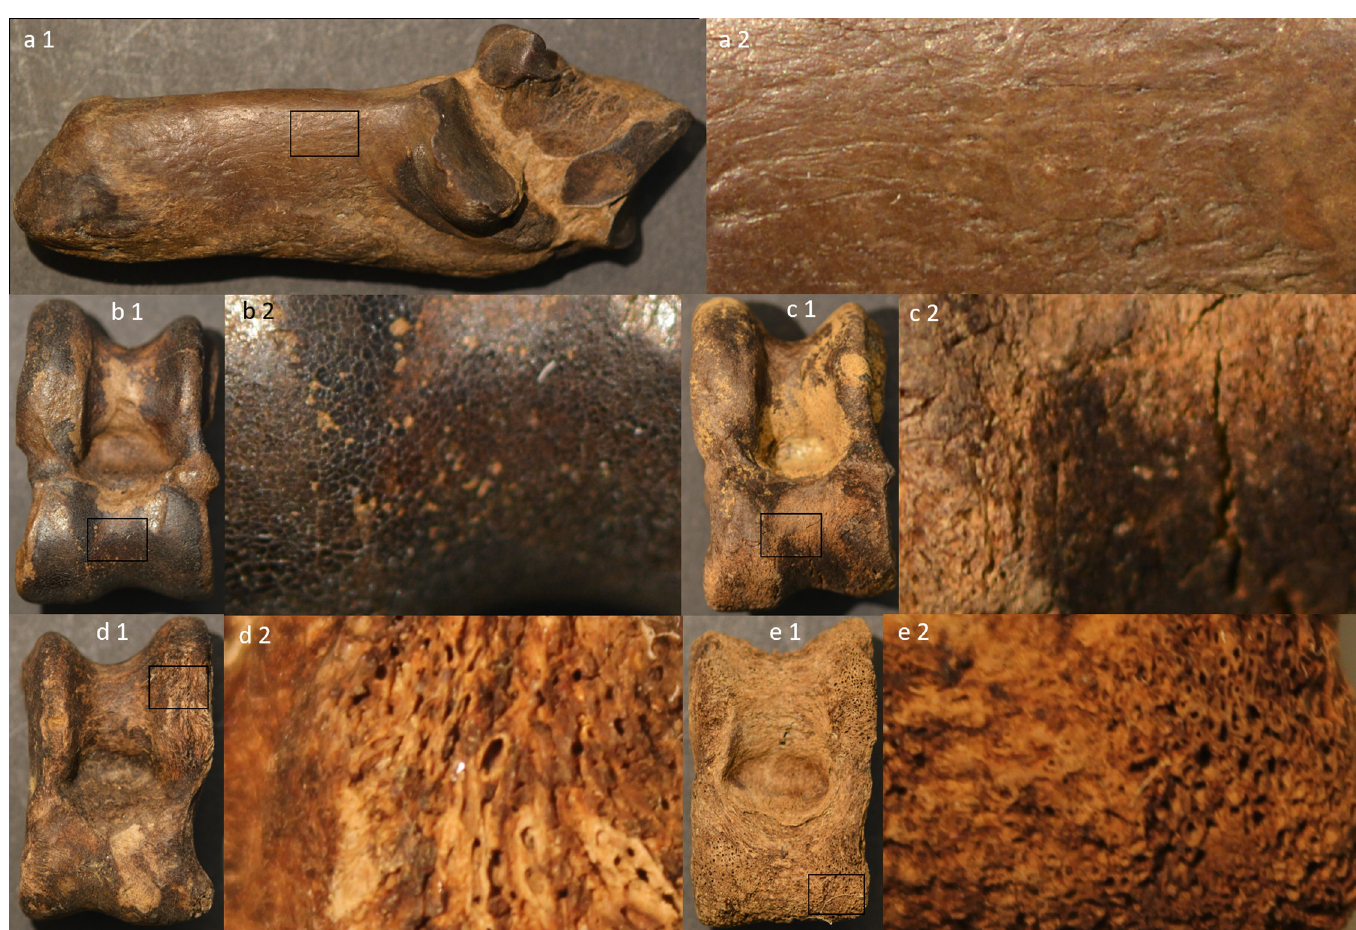
Fig 6. Weathering I categories exemplified with bones from the 1940s excavation campaign. a: Wild boar calcaneus weathering category 1, b: Red deer astragalus weathering category 2, c: Red deer astragalus weathering category 3, d: Red deer astragalus weathering category 4 (lower end of category 4 spectrum), e: Red deer astragalus weathering category 4 (upper end of category 4 spectrum). Image created for this publication by the authors (OM and AB).